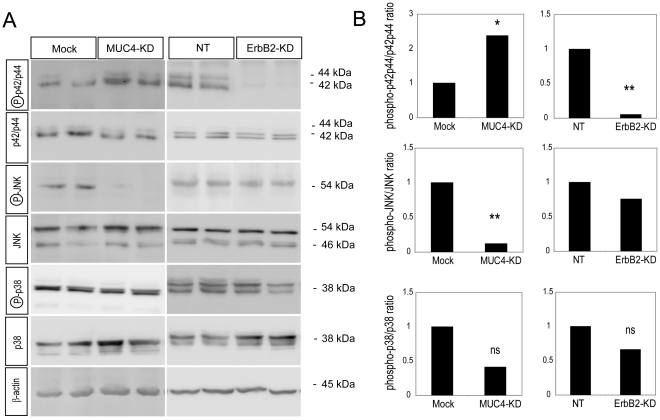
Impact of ErbB2 and MUC4 on MAPK/SAPK (p42/p44, JNK, p38) signalling pathways.(A) Western blot analyses were carried out on cytosolic extract of MUC4-KD, ErbB2-KD and controls (Mock and NT respectively) for expression of both phosphorylated and constitutive forms of p42/p44, JNK and p38 MAPK. β-actin was used as the internal control. Two representative clones are presented. (B) Bands were quantified by densitometry. Histograms of the ratio (phosphorylated/constitutive form) for p42/p44, JNK and p38 MAPK kinases are shown.